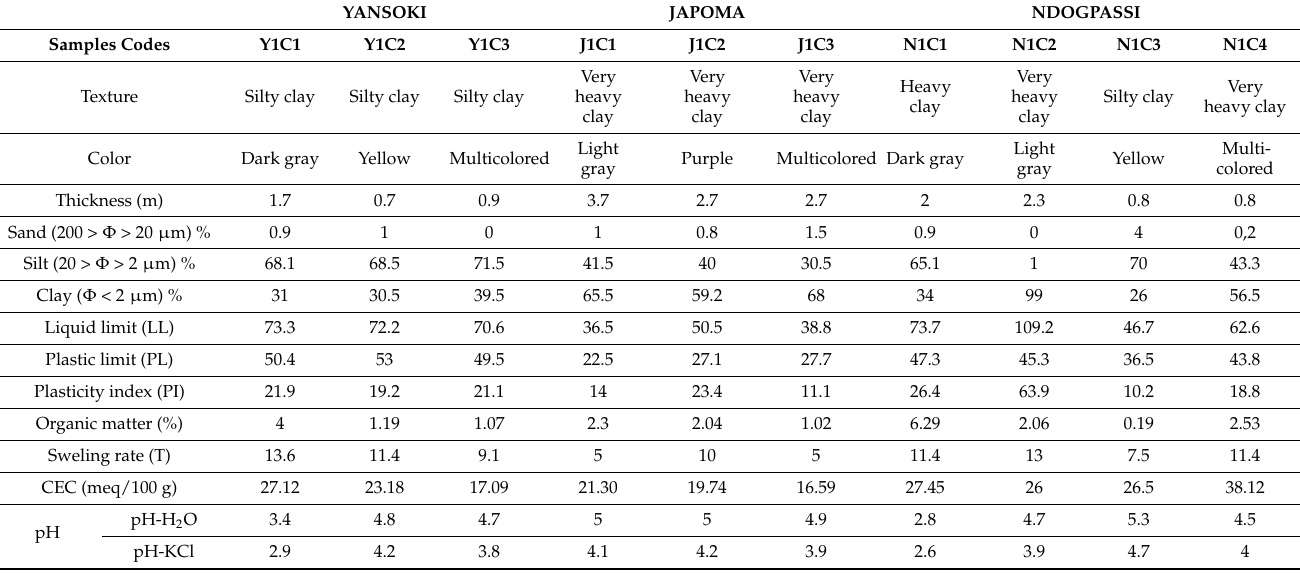
Table 3. Physicochemical parameters of the studied clays of the eastern part of the Douala sub-basin.